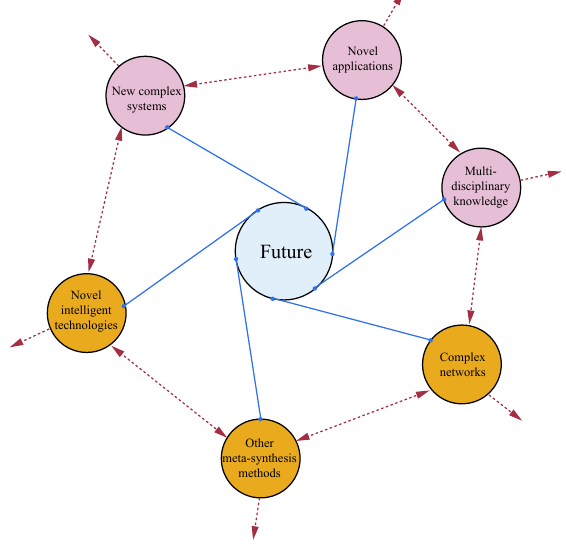
Fig. 10 Illustration of future